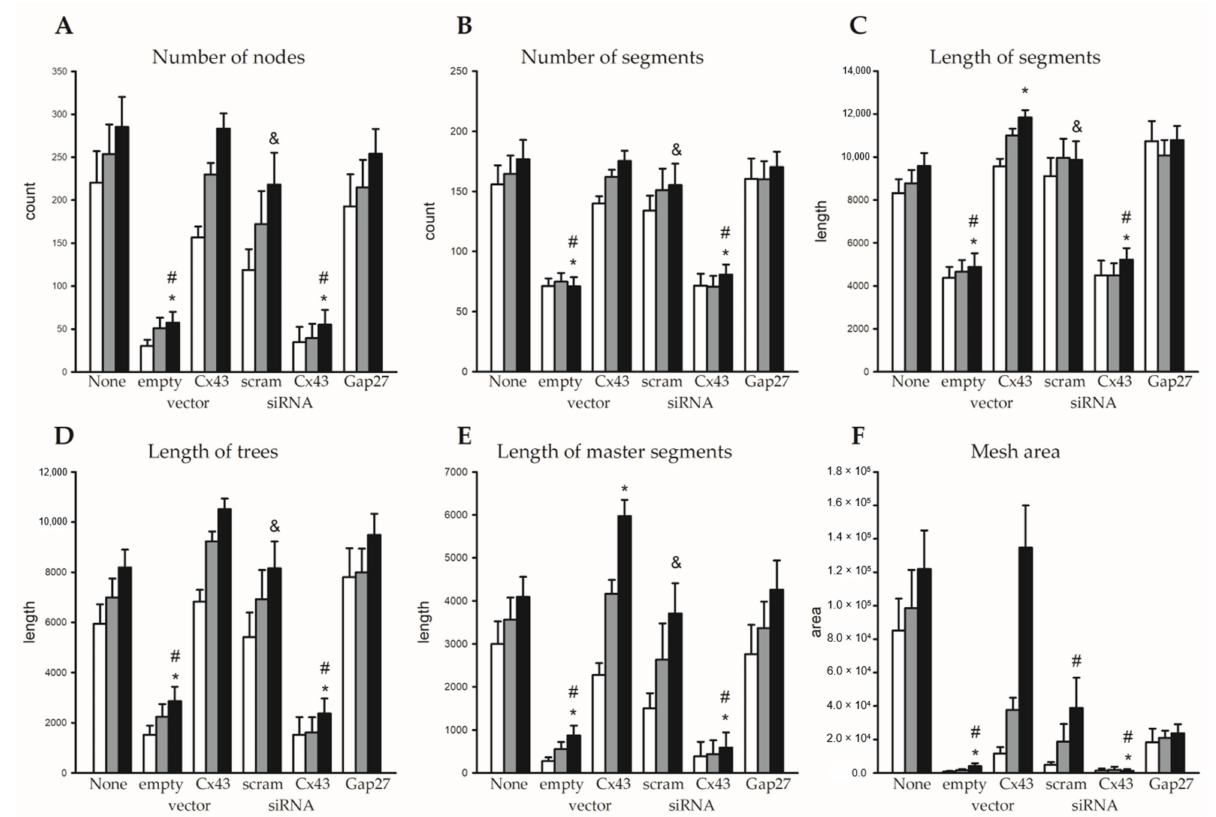
Figure 4. Angiogenic potential of HUVECs was modulated by Cx43 expression but did not depend on GJ communication. Quantitative analysis of tube formation assays in different treatment groups 2 h (white bars), 4 h (grey bars), and 6 h (black bars) after the start of the assay. Number of nodes ( A ) and segments ( B ); total sum of the length of segments ( C ), trees ( D ), or master segments ( E ); as well as the area of meshes ( F ) are depicted. In comparison to non-treated HUVECs ( n = 38), transfection of the empty vector ( n = 23) reduced all parameters of angiogenesis, which was overcome if Cx43 cDNA ( n = 23) was transfected. Treatment with Cx43 siRNA ( n = 19) likewise abrogated the angiogenic potential, which was not observed for scrambled siRNA (scram, n = 10). Treatment with Gap27 after transfection of Cx43 cDNA ( n = 11) was without effect on angiogenesis. Statistical analysis was only performed at timepoint 6 h. * p < 0.05 vs. non-treated HUVECs, # p < 0.05 vs. Cx43 cDNA, & p < 0.05 vs. Cx43 siRNA (only analyzed for scrambled siRNA), one-way analysis of variance (ANOVA) followed by Bonferroni multiple-comparison